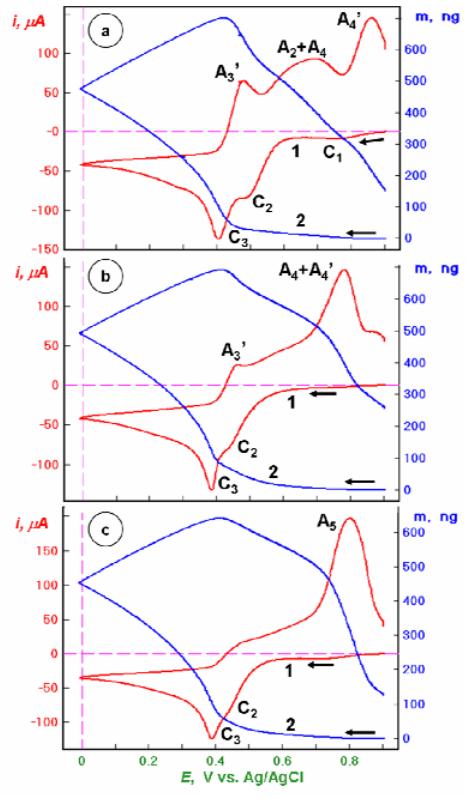
Figure 3. Linear potential scan voltammetric (1) and nanogravimetric (2) characteristics of piezosensors: (a) bare Au, (b) Au/CA, and (c) Au/CA-GSH, recorded in 0.1 M NaClO mM HClO + 1.5 mM Hg(ClO ) solution, in the potential range from E = +0.9 to 0 V vs. 4 4 2 Ag/AgCl, at a scan rate v = 50